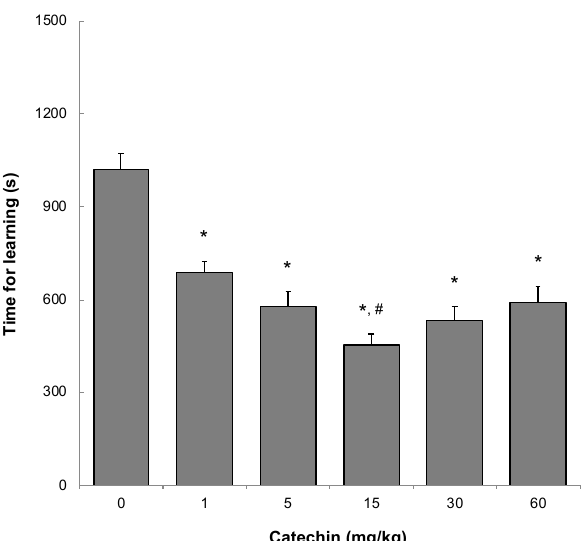
Figure 2. Effect of GT-catechin ingestion on learning ability of SAMP10 mice. A step-through passive avoidance task was carried out using 11-month-old mice. When a mouse entered a dark chamber from a light chamber, the door was closed and an electric foot-shock was delivered at 50 µA for 1 s. Acquisition of the avoidance response was judged as successful if the mouse remained in the light chamber for 300 s. The trial was repeated until the mouse satisfied the acquisition criterion within five trials. This result from successive trials was summed for each mouse to give a measure of the time required for learning not to enter the light chamber (i.e., learning time) (n = 16–24; * p < 0.05 to control, # p < 0.05 to mice that ingested 1 mg/kg).